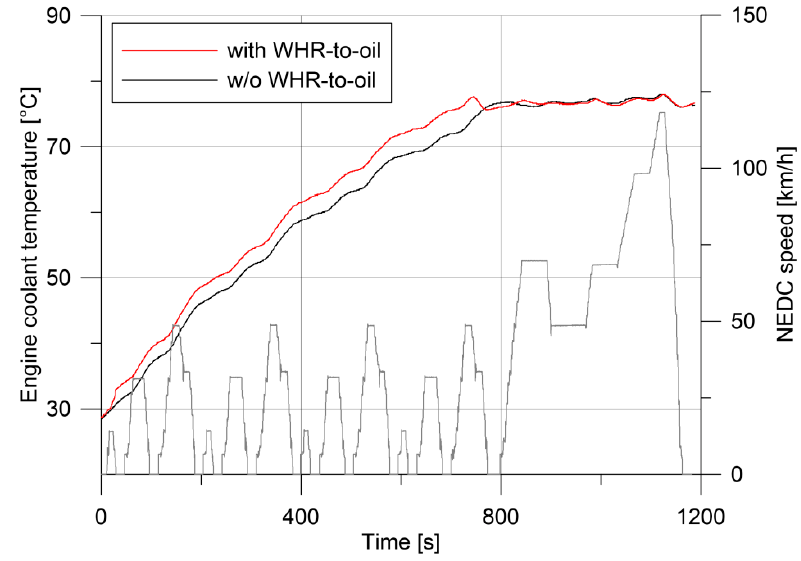
Figure 13. Engine coolant temperature in the thermostat valve in the two test cases performed.